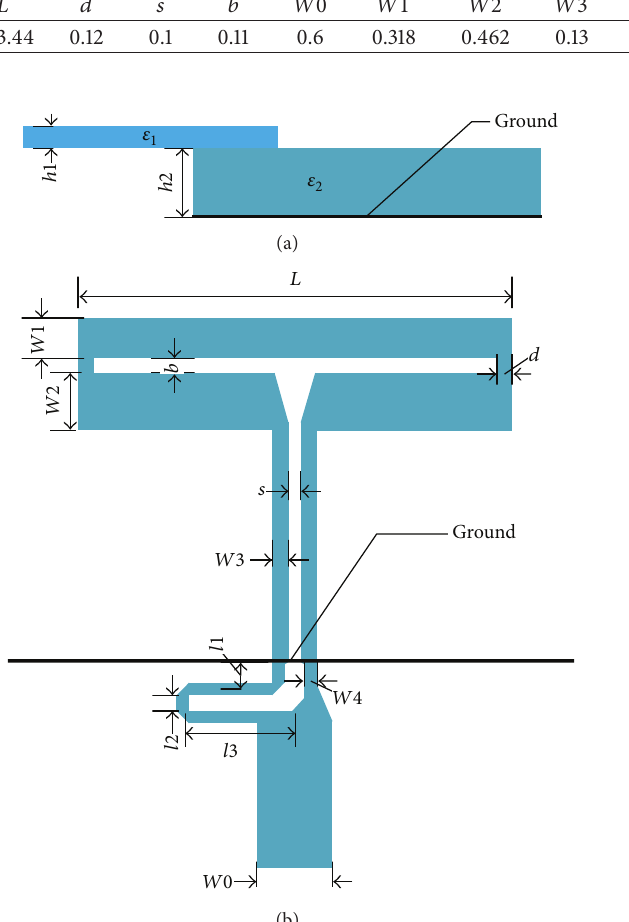
Figure 1: The construction of the antenna: (a) side view; (b) top view.